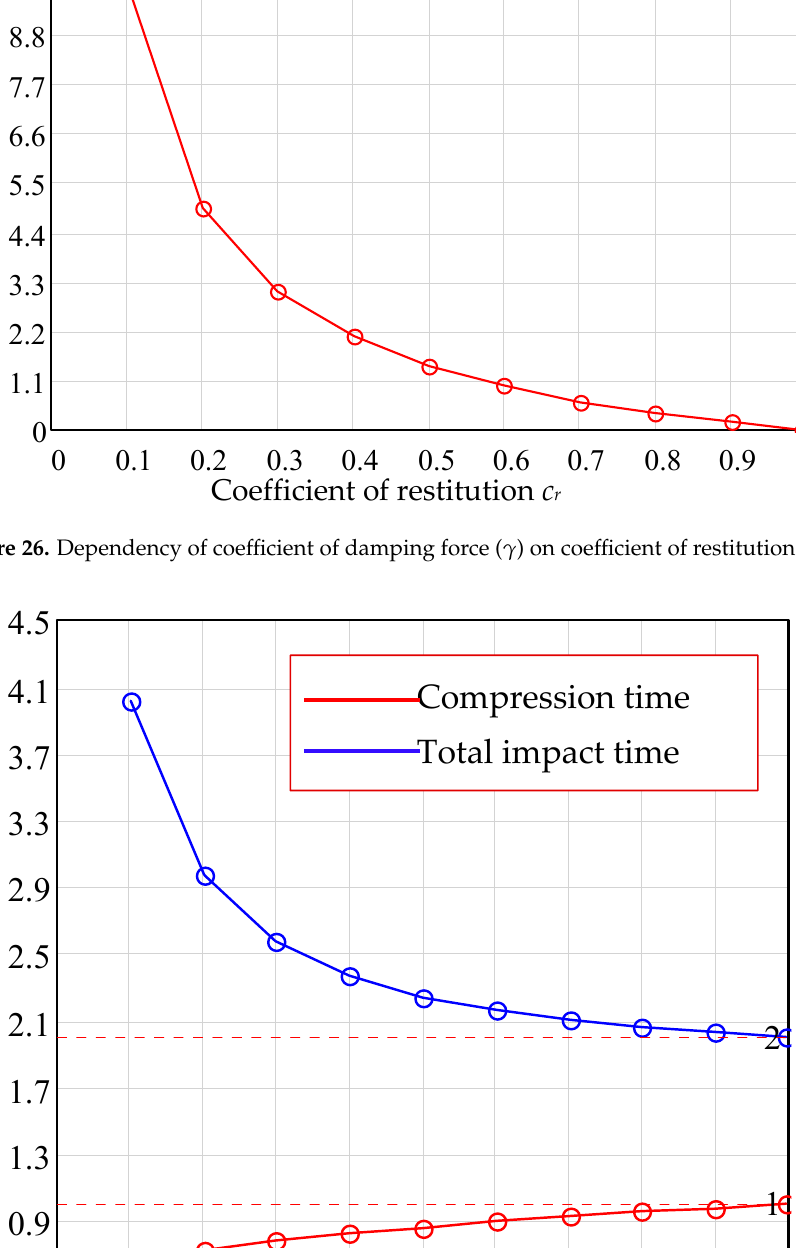
) and total impact time ( 𝑡 (cid:3004)